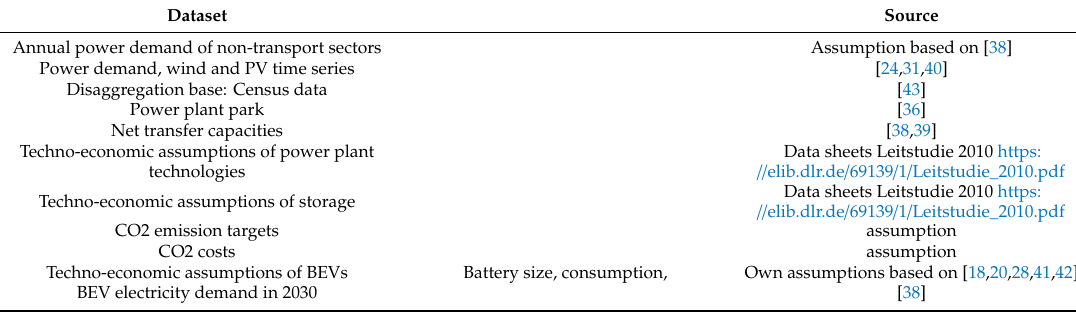
Table A7. Secondary sources for the transparency